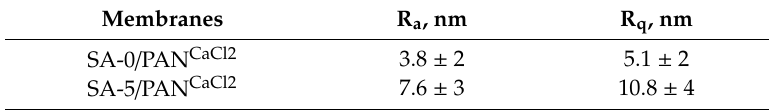
Table 6. Surface parameters of the supported SA-0/PAN CaCl2 and SA-5/PAN CaCl2 membranes.